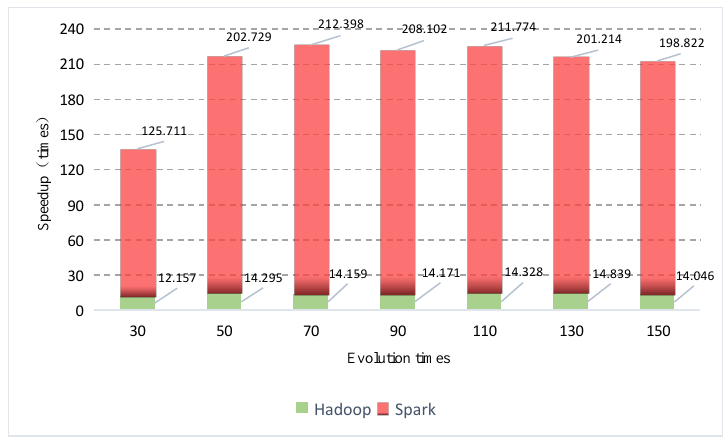
Figure 13. Comparison of the speedup ratio with different evolution times.